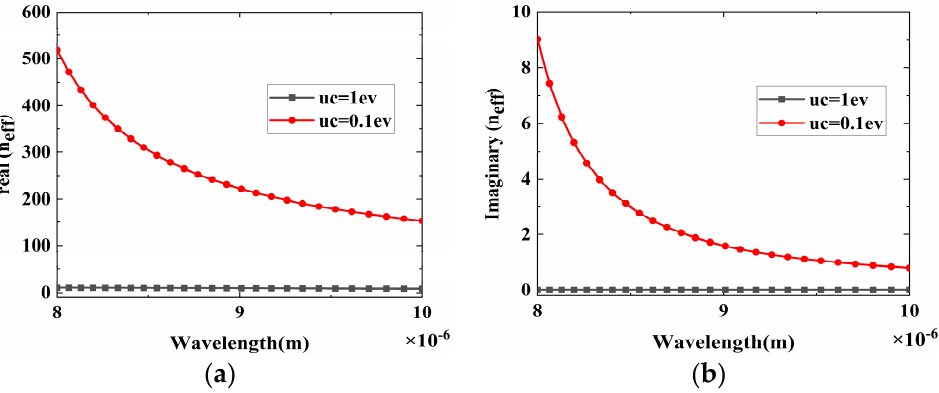
Figure 3. Effective refractive index of graphene in the real part ( a ) and the imaginary part ( b ) as a function of chemical potential at 8 μ m < λ < 10 μ m.